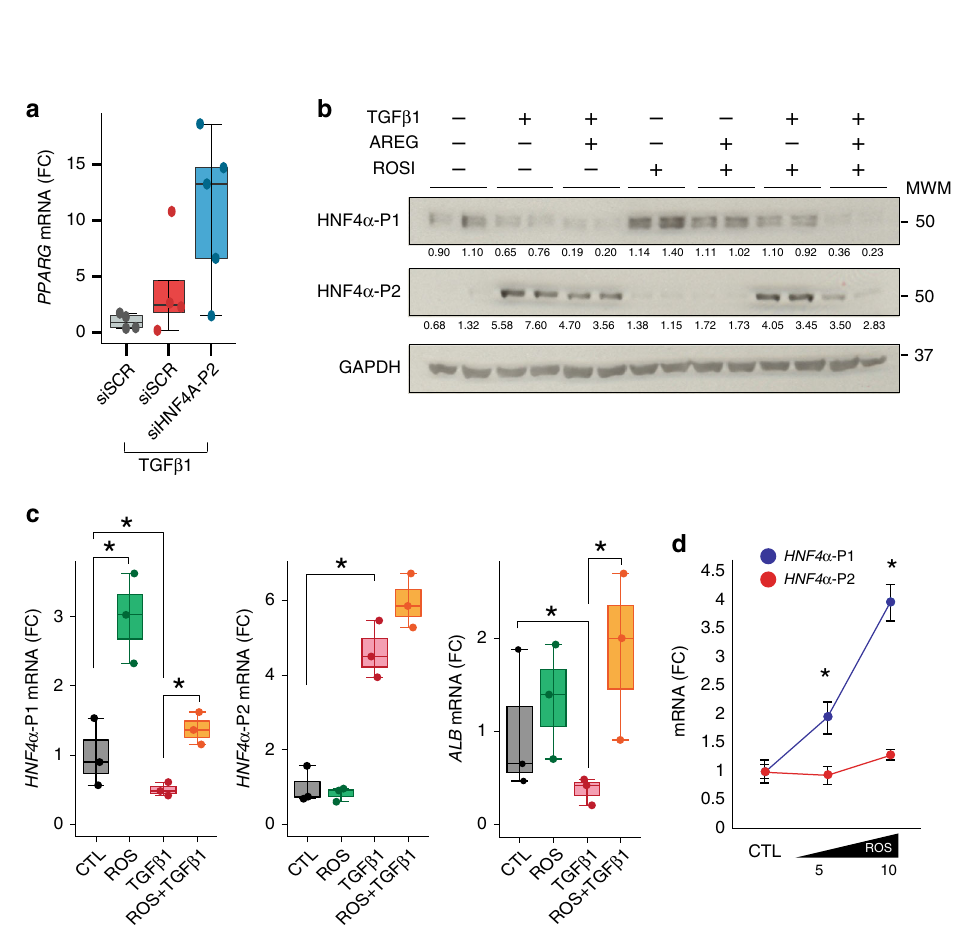
Fig. 6 PPAR γ agonist Rosiglitazone partially restores TGFB1-induced HNF4A de-regulation. a HepG2 cells were transfected with HNF4 α -P2 siRNA for 48 h and collected 8 h after TGF β 1 treatment (5 ng/ml) ( n = 5 for each condition);qPCR of PPAR γ . b , c Hep3B cells were pretreated with rosiglitazone (10 μ M) overnight and then treated with TGF β 1 (5 ng/ml) and/or AREG (50 nM) for 8 h ( n = 3 for each condition); b Immunoblot of HNF4 α -P1 and HNF4 α -P2 c qPCR of HNF4 α -P1 and P2 isoforms and ALB . d Hep3B cells were treated with rosiglitazone at doses of 5 and 10 μ M, and harvested 16 h after treatment; qPCR of HNF4 α -P1 and P2 isoforms ( n = 3 for each condition). Signi fi cance was determined by two-tailed Mann – Whitney U test in a , b and d : * P < 0.05. For box-and-whisker plots: perimeters, 25th – 75th percentile; midline,